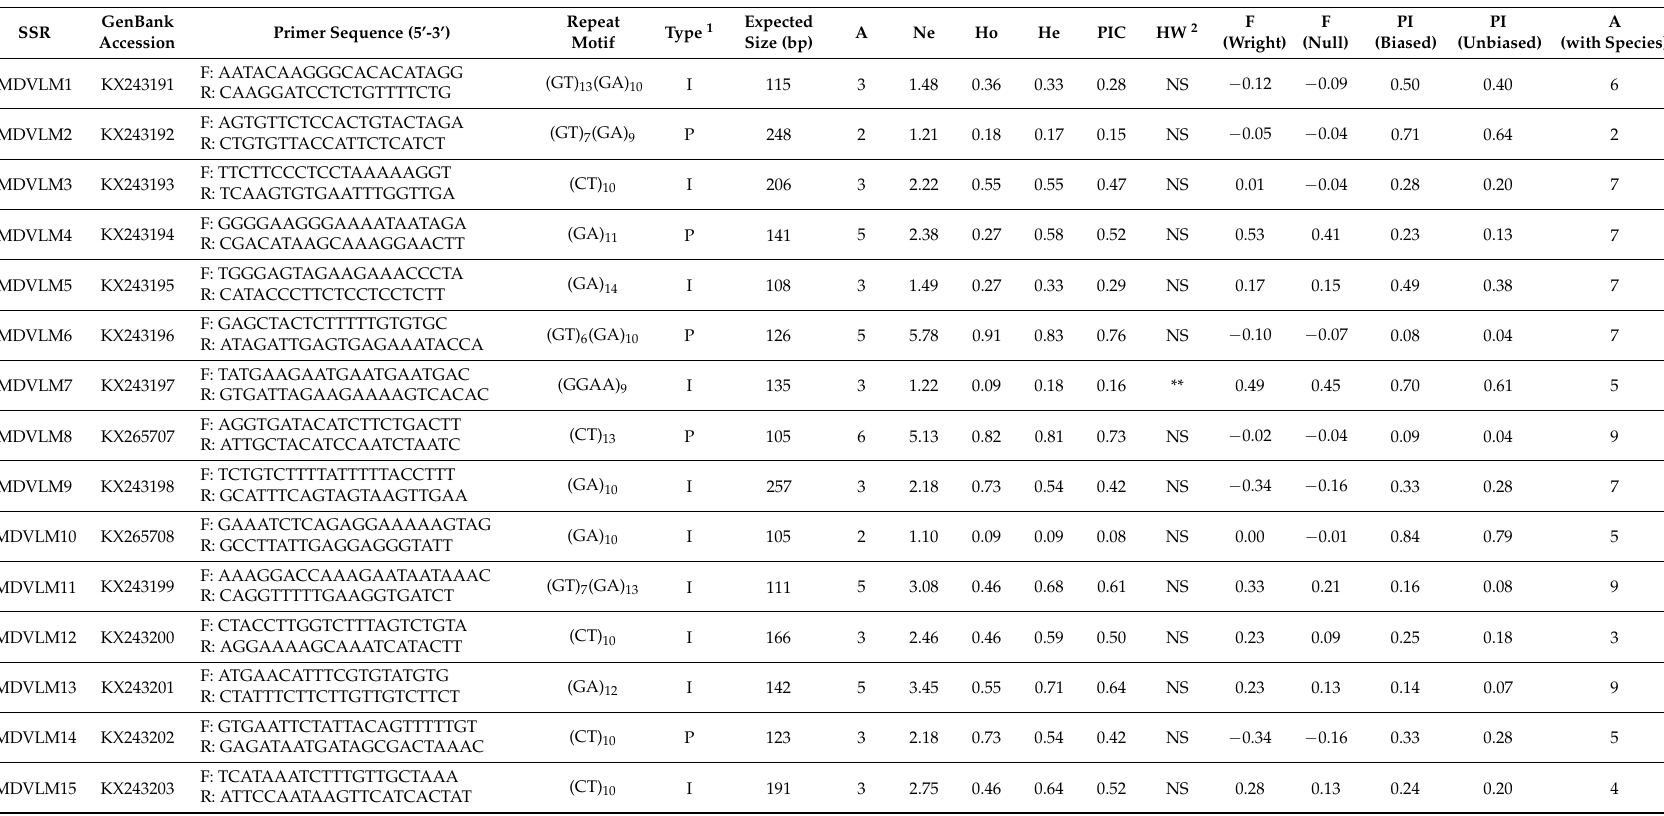
Table 1. Locus name, GenBank accession number, primer sequences, repeat motif and types, length of the expected amplified fragment and variability parameters in 11 Mandevilla